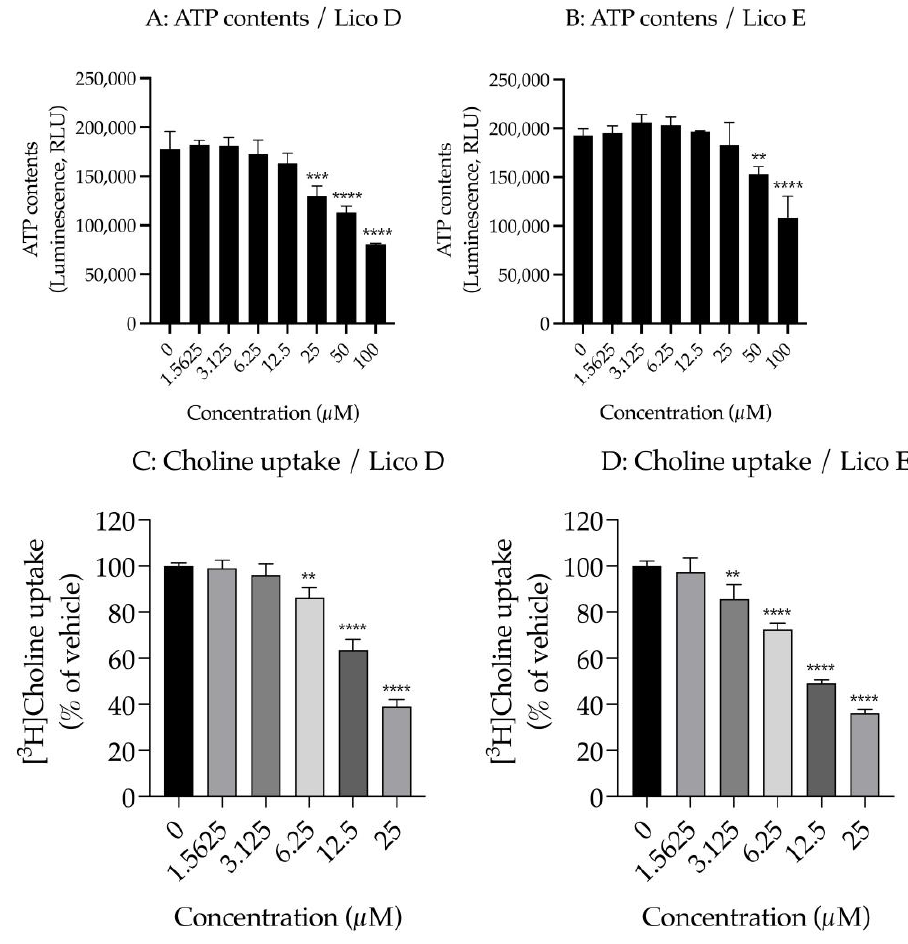
Figure 4. Effects of Licos D and E on membrane permeability and [ 3 H]choline uptake in SIM-A9 cells. ATP contents were measured after treatment with 1.5625 – 100 µM of Licos D ( A ) and E ( B ) for 40 min. ATP contents were determined using the CellTiter-Glo ® Luminescent Cell Viability Assay. After preincubation of Licos D ( C ) and E ( D ) for 20 min, 10 µM [ 3 H]choline was added and uptake was measured for 20 min. IC 50 values of Licos D and E for inhibition of [ 3 H]choline uptake were 17.1 and 12.4 μM, respectively. The results are presented as a percentage of uptake measured with the vehicle control. Values are the mean ± SD ( n = 4). ** p < 0.005, *** p < 0.0005 and **** p < 0.0001 compared with vehicle control. Statistical analysis of the data was performed using Dunnett’s multiple comparisons test.